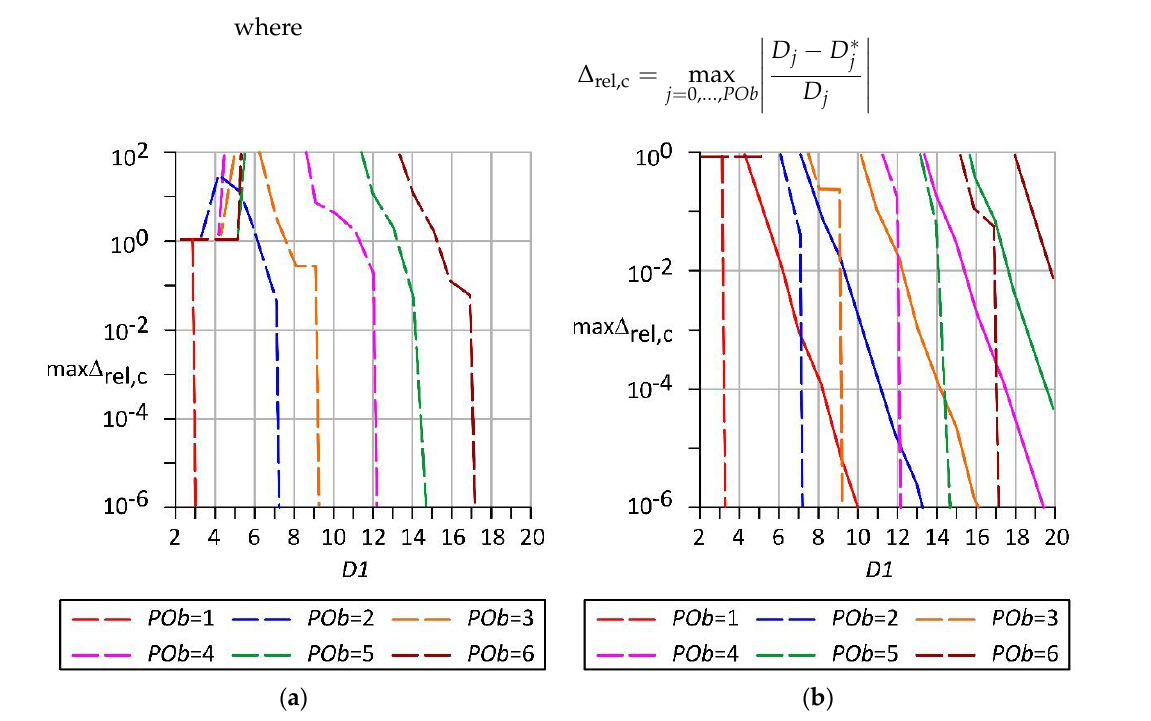
Figure 4. The maximum relative error of the base polynomial coefficients max Δ rel,c for various POb and the number of significant digits of rounding D 1: ( a ) considering only the polynomial dependences, ( b ) considering the polynomials and all the other groups of functions.